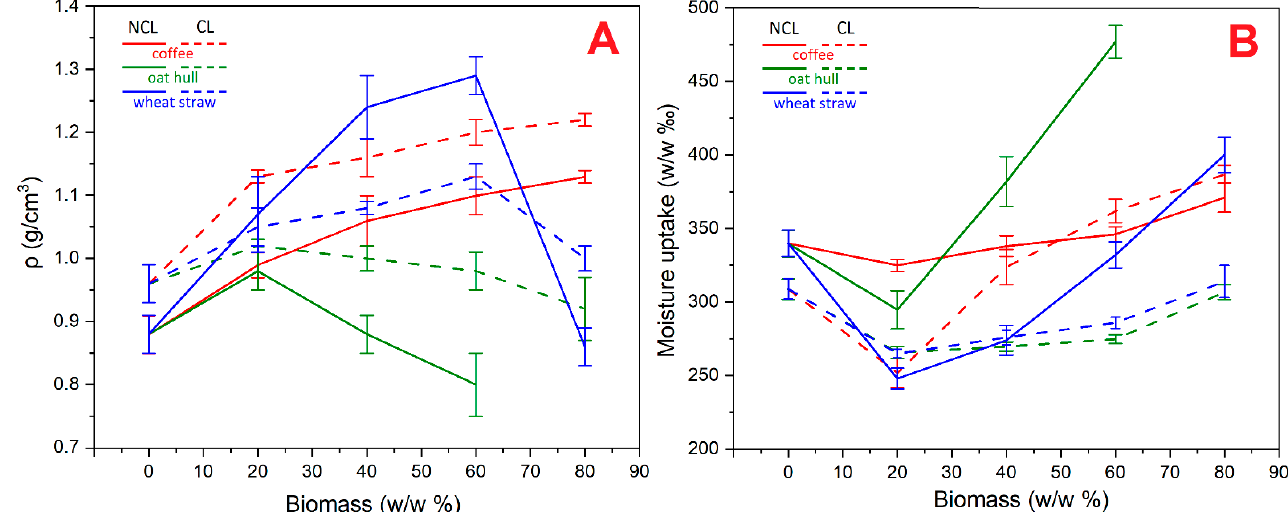
Figure 5. Comparative charts of density ( ρ ) vs. biomass content (%) ( A ), and a comparison of vapor uptake ( w/w ) vs. biomass content ( B ) for crosslinked (CL) and non-crosslinked (NCL) composite materials in their dry state.